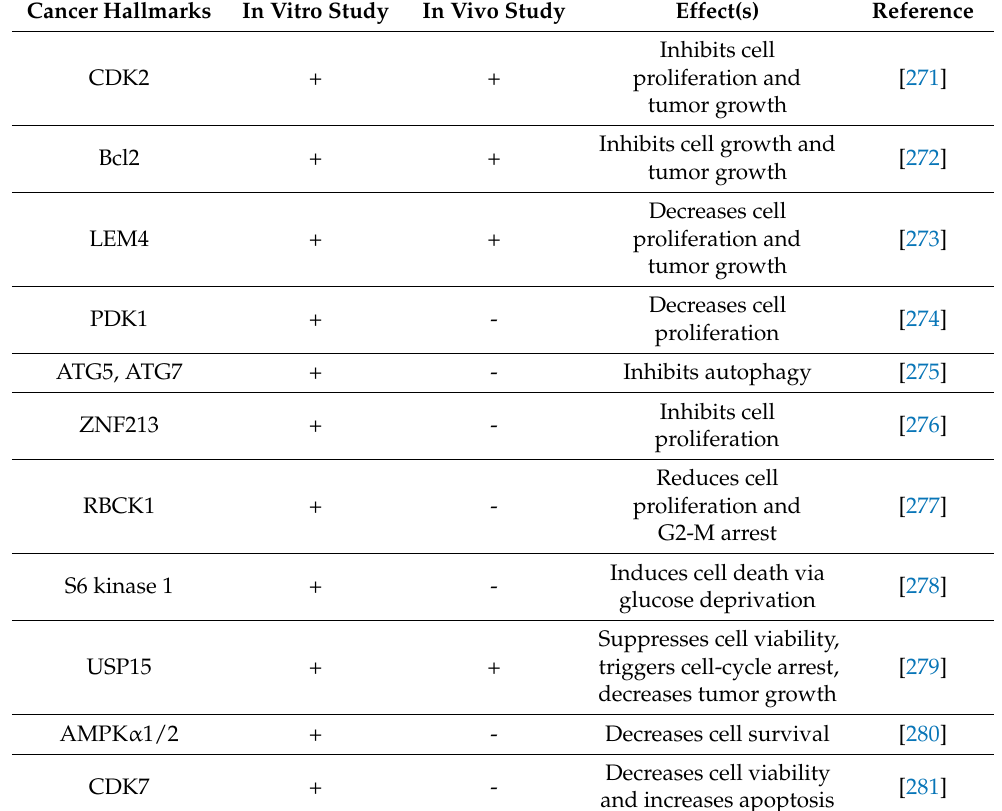
Table 2. Cont. Cancer